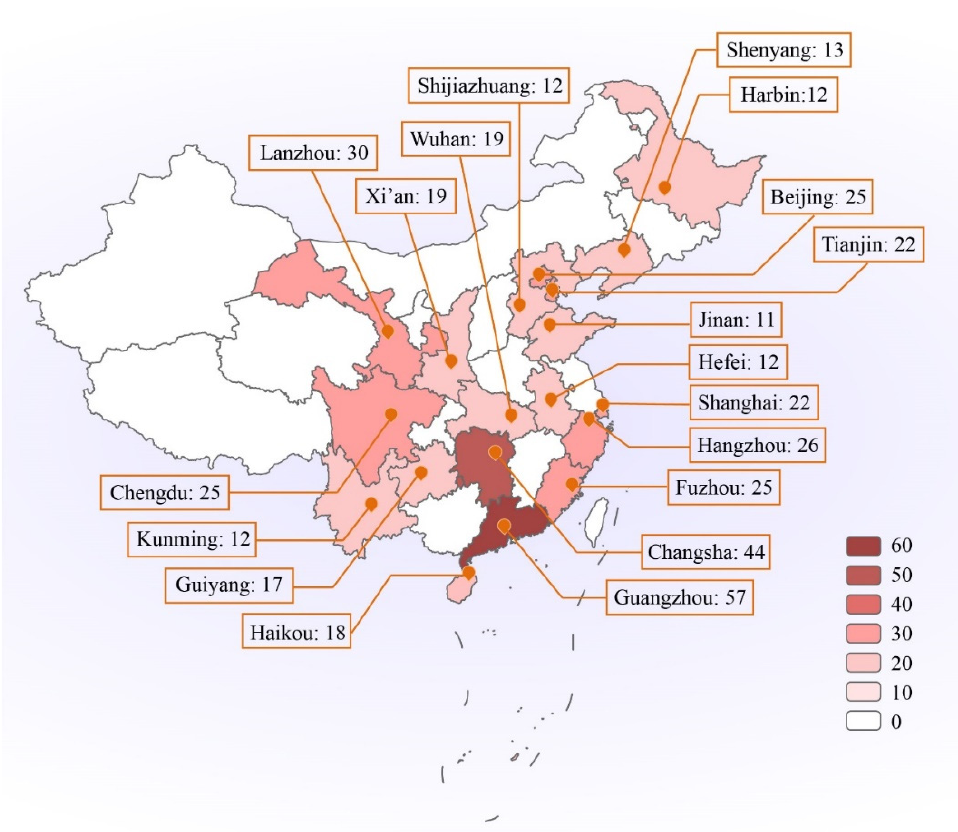
Figure 1. The distribution of participants in mainland China. Note. The number of participants is indicated in the map, the city of the participants’ living is marked by orange icon. The darker colour represents the greater numbers of participants.